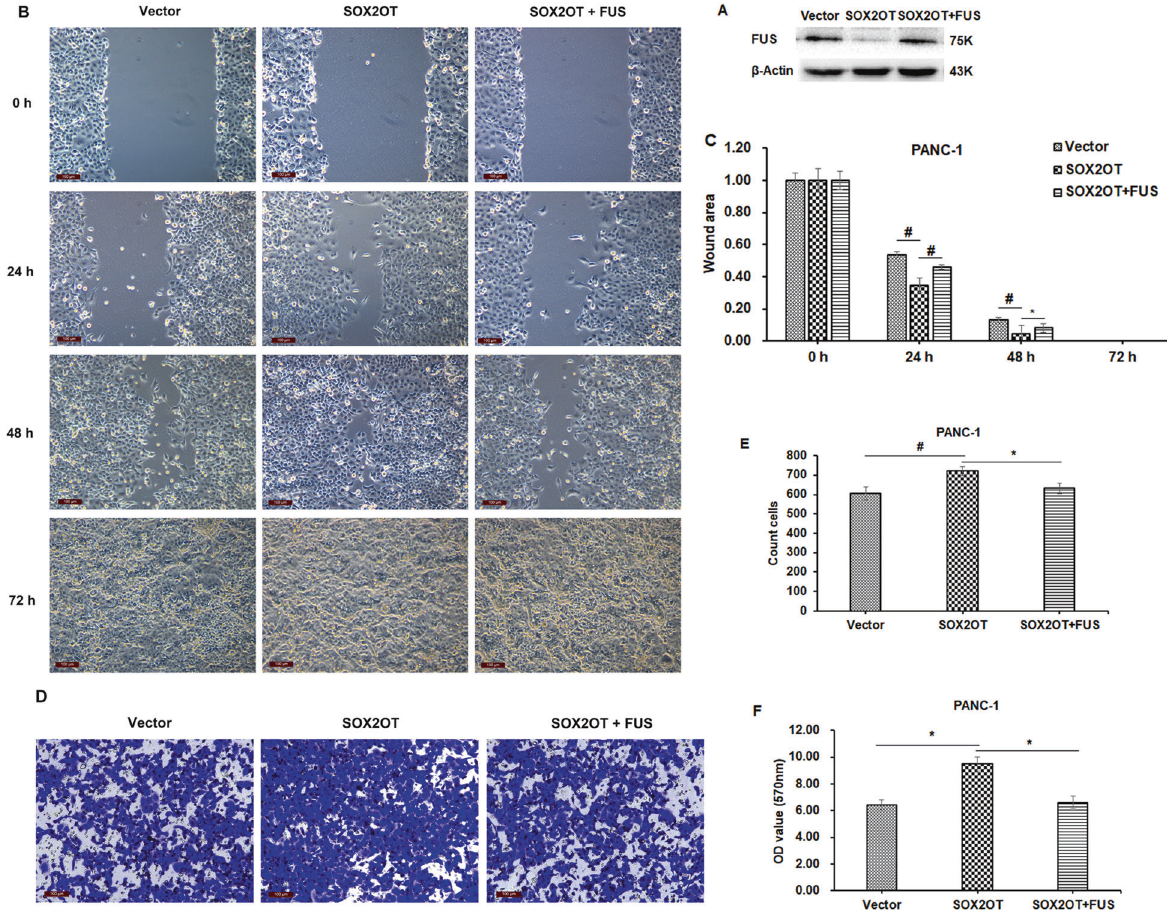
Fig. 2 SOX2OT – FUS regulatory axis promotes in vitro migration and invasion ability of pancreatic cancer cells. A FUS expression in PANC- 1 – Vector, PANC-1 – SOX2OT, and PANC-1 – SOX2OT – FUS cells was con fi rmed by western blot analysis. B Cell wound healing assays were performed. Phase images were taken at 0, 24, 48, and 72 h, respectively. Magni fi cation, ×100. The relative wound areas ( C ) were measured by Image-Pro Plus software. D Cellular transwell assays were performed. The membranes of the chambers were stained with 0.1% crystal violet and photographed. Magni fi cation, ×200. E The cells in fi ve random fi elds of view were counted. F The stained cells were soaked in 33% acetic acid and the absorbance of 33% acetic acid containing crystal violet was assessed using a microplate reader at a 570 nm wavelength. The optical density (OD) value indirectly re fl ected the number of penetrated cells. (* represents p < 0.05, # represents p < 0.001, compared with the control